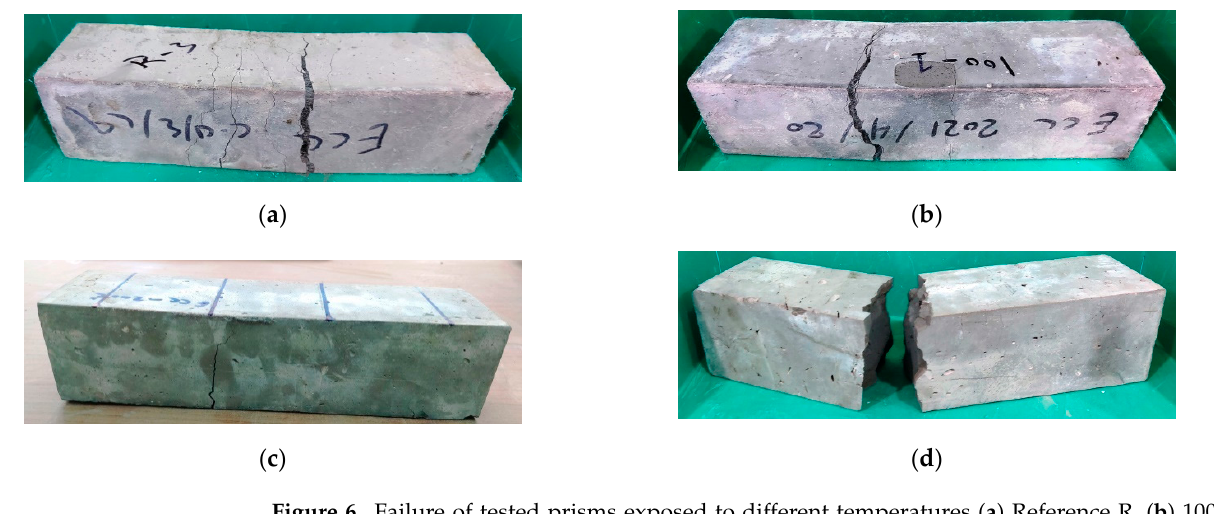
Figure 6. Failure of tested prisms exposed to different temperatures ( a ) Reference R, ( b ) 100 °C, ( c ) 200 °C, ( d ) 300 °C.